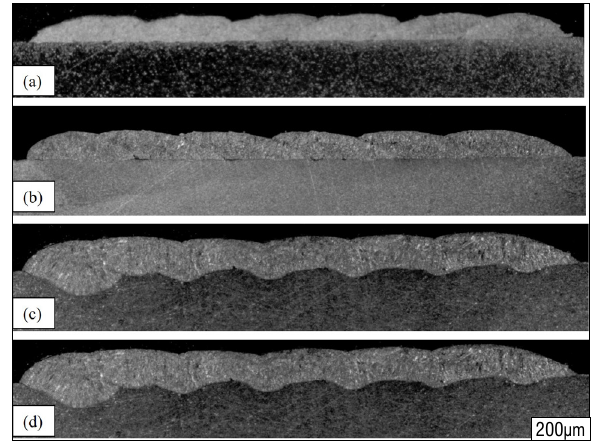
Figure 2: Overall view of samples: (a) A1, (b) A2, (c) A3, and (d)